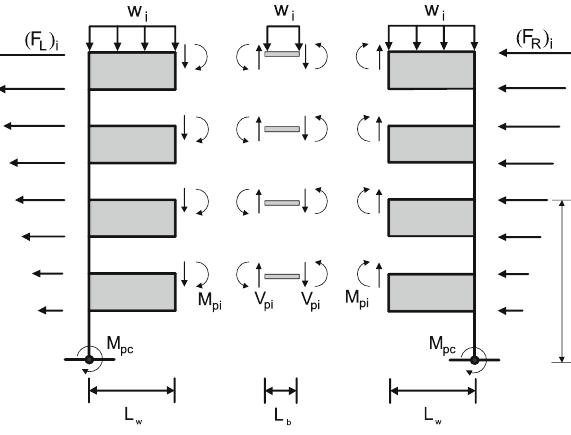
Fig. 13 Free body diagram of the model